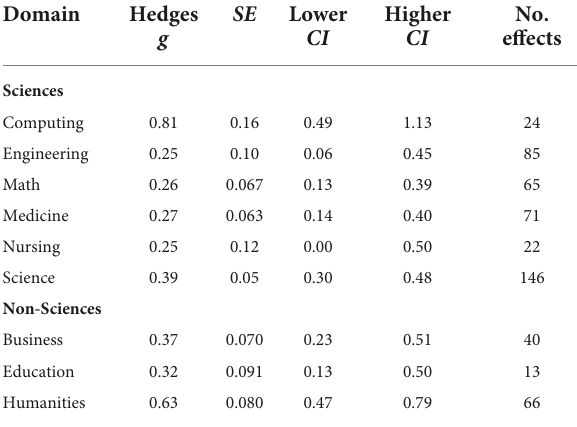
TABLE 3 Hedges g effect-size moderated by domain. TABLE 4 Hedges g effect-size moderated by